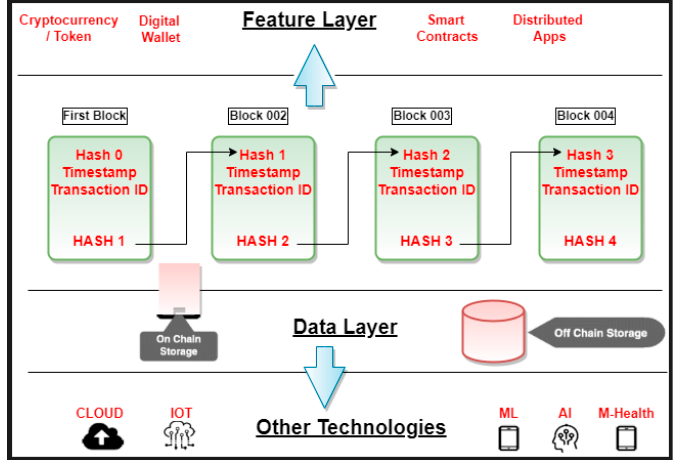
Figure 1. Blockchain in its simplest form.